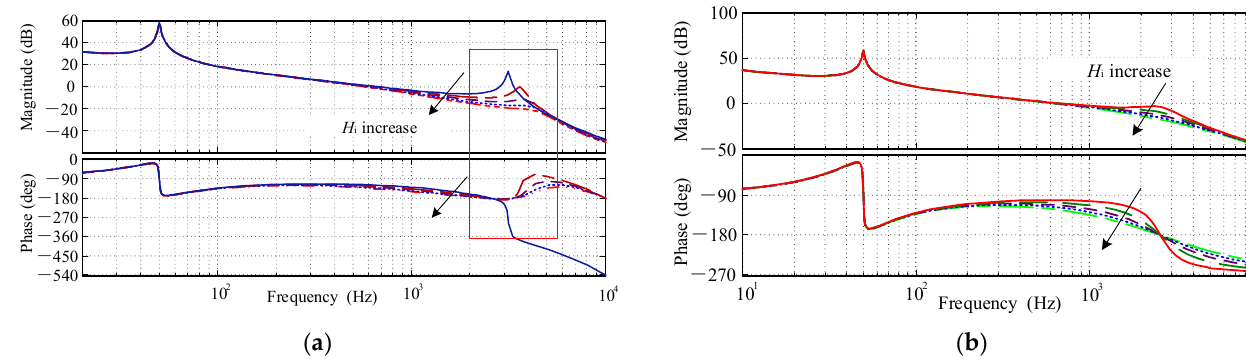
Figure 3. Comparison of transfer function Bode diagrams with different active damping coefficients: ( a ) considering the digital delay; ( b ) without considering the digital delay.